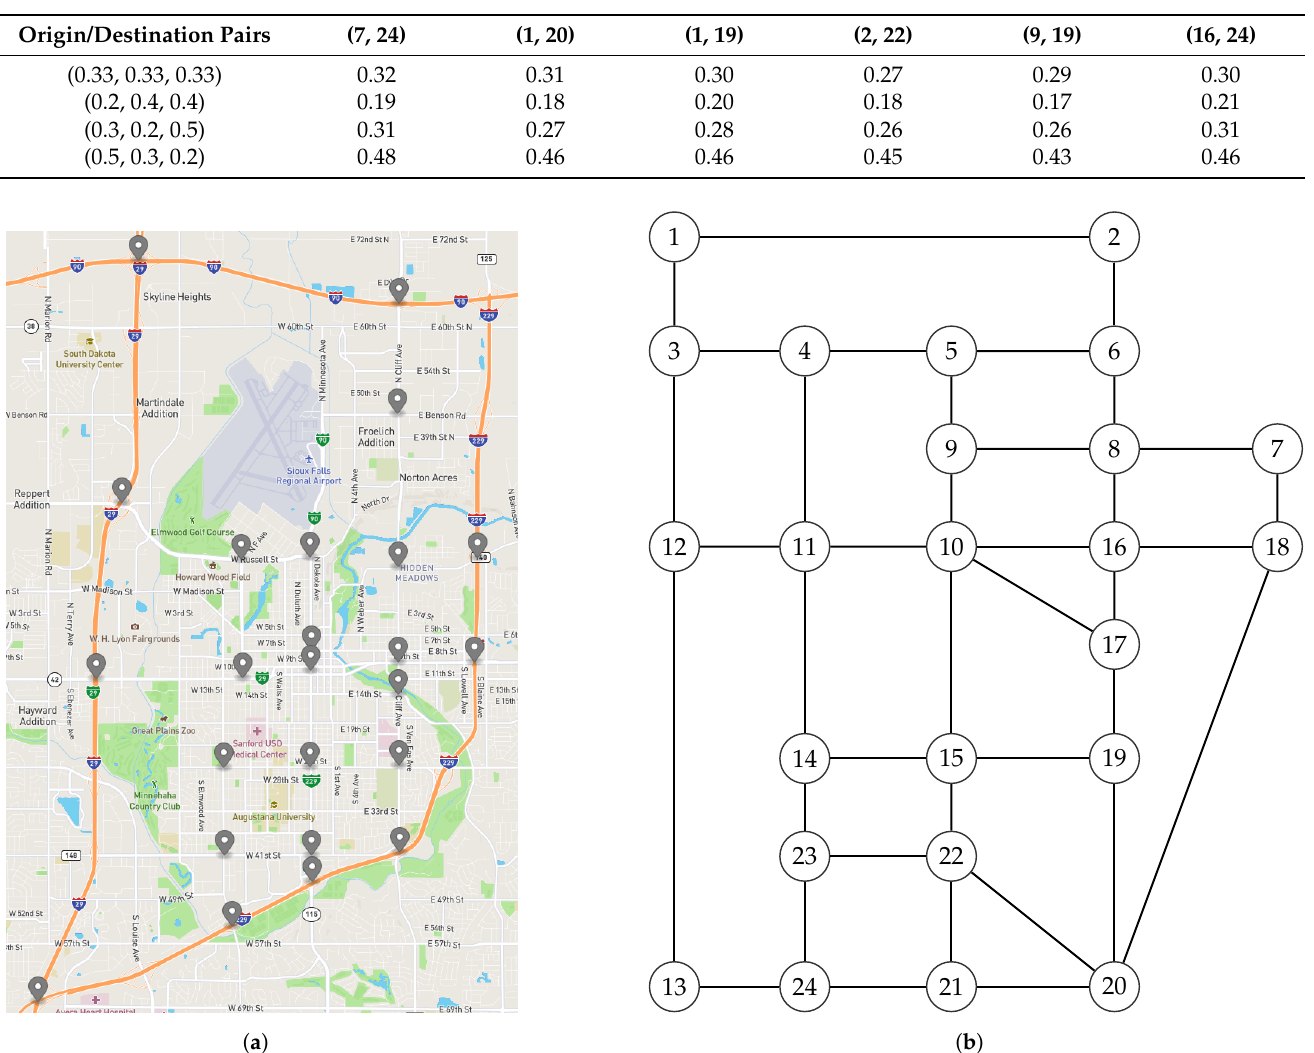
Table 1. The optimal comprehensive cost for six different OD pairs with four parameter settings.